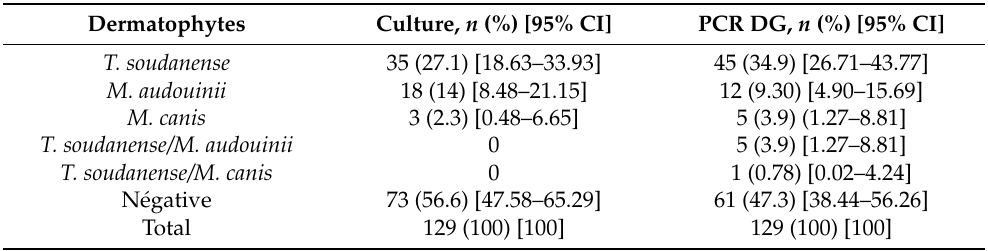
Table 3. Species identified by culture and complete multiplex real-time PCR DermaGenius ® (DG PCR) in hair samples ( n = 129).